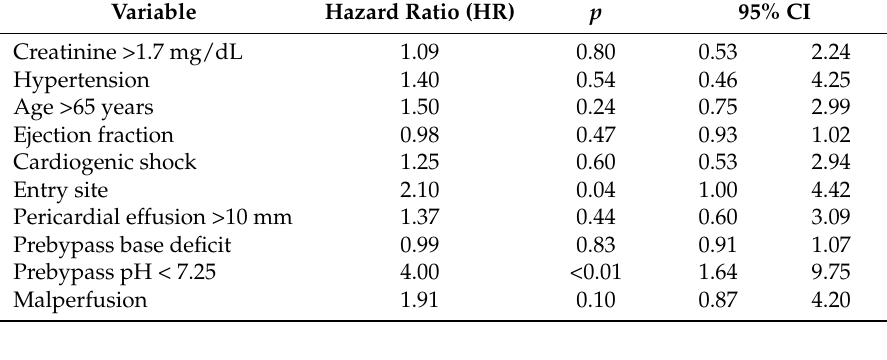
Figure 2. Kaplan–Meier curve depicting global survival of the entire cohort. Table 3. Cox regression analysis for early hazard phase (<30 days).